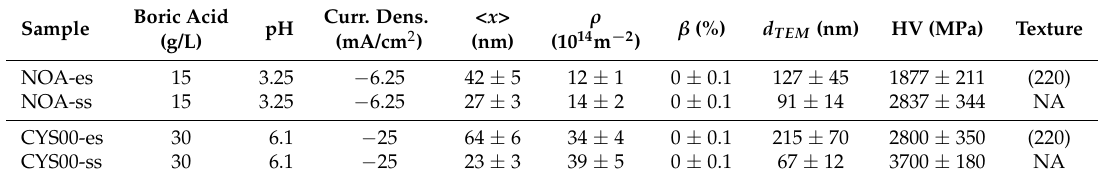
Table 3. The difference between the conditions of electrodeposition of the additive-free sample from Ref. [8] (denoted as “NOA”) and the additive-free sample used in this study (denoted as “CYS00”) and a comparison between the microstructural parameters, texture and hardness.